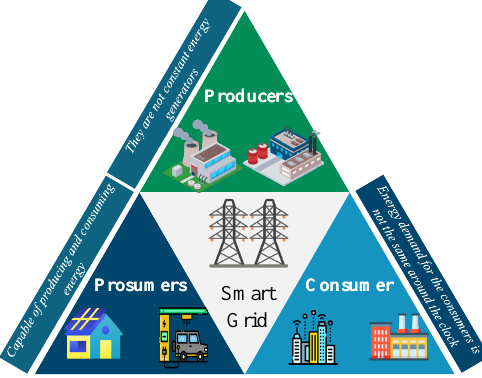
Figure 1. Actors involved in SG